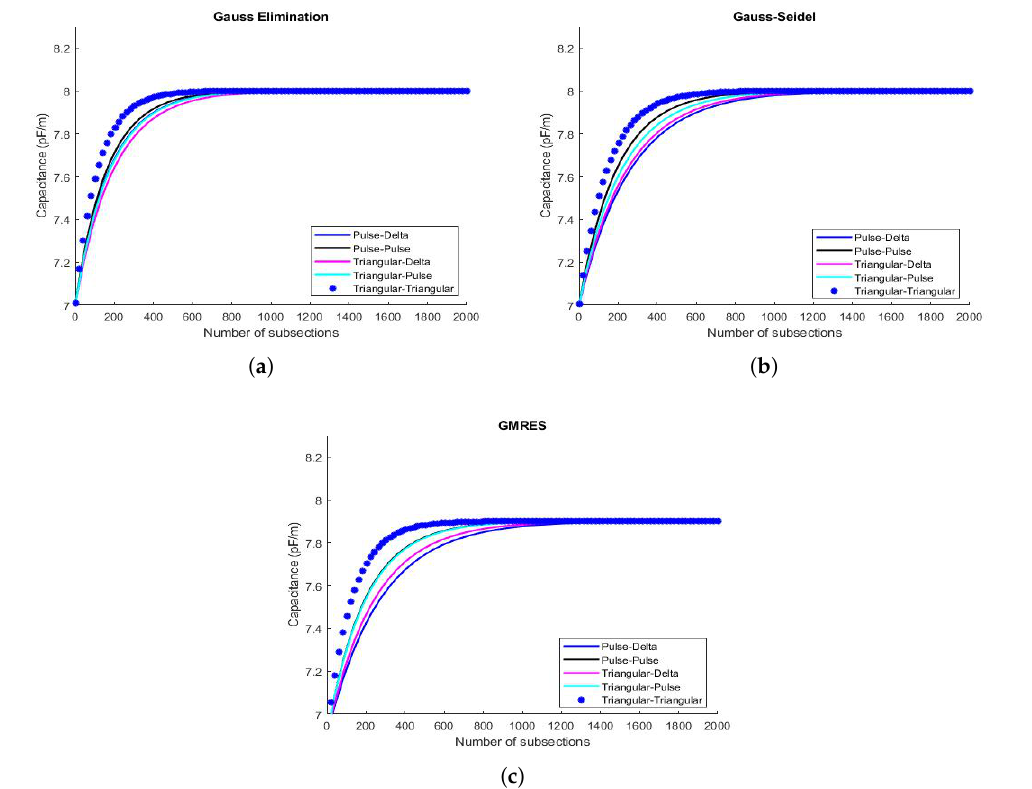
Figure 6. C vs. N when L / d ratio is equal to 400 for each basis and testing functions: ( a ) Gauss elimination; ( b ) Gauss–Seidel procedures; ( c ) GMRES